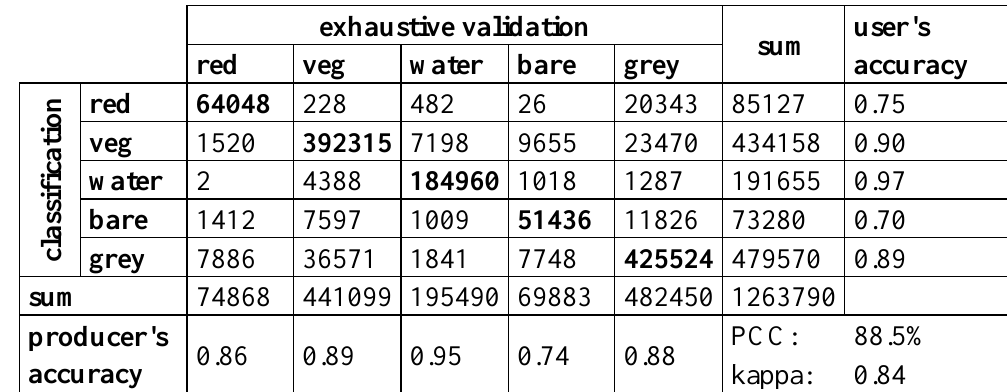
Table 6. Confusion matrix for the full hierarchic multi-layer perceptron classification result after shadow